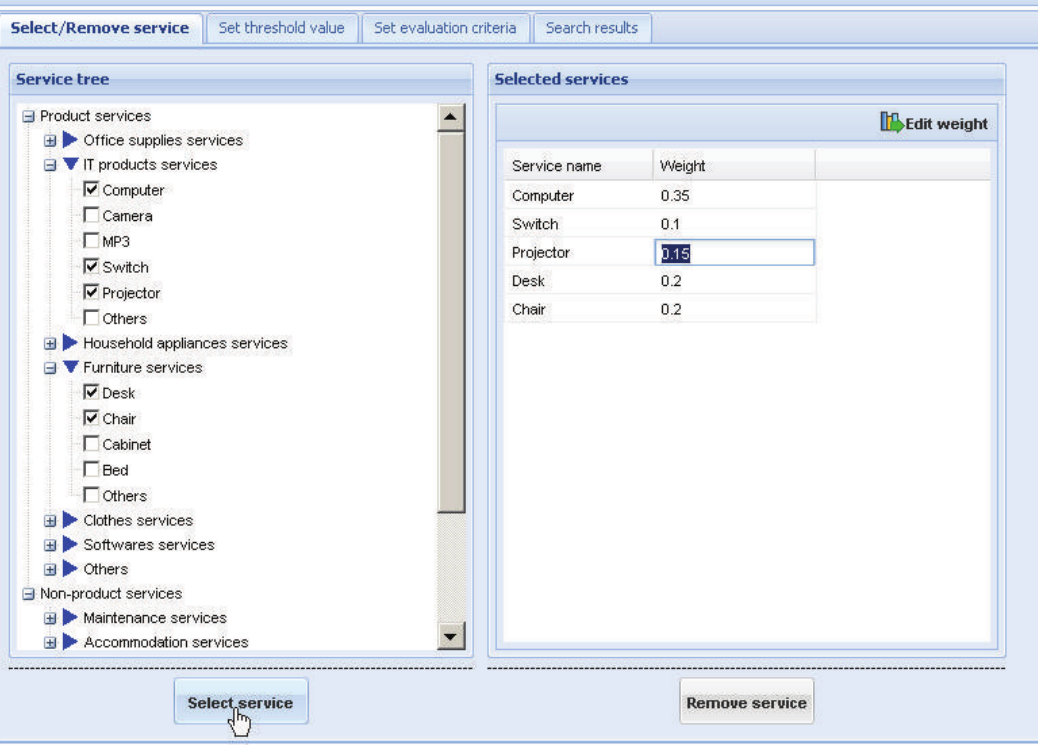
Figure 3: Graphical user interface for procurement scheme optimization system in the prototype system.